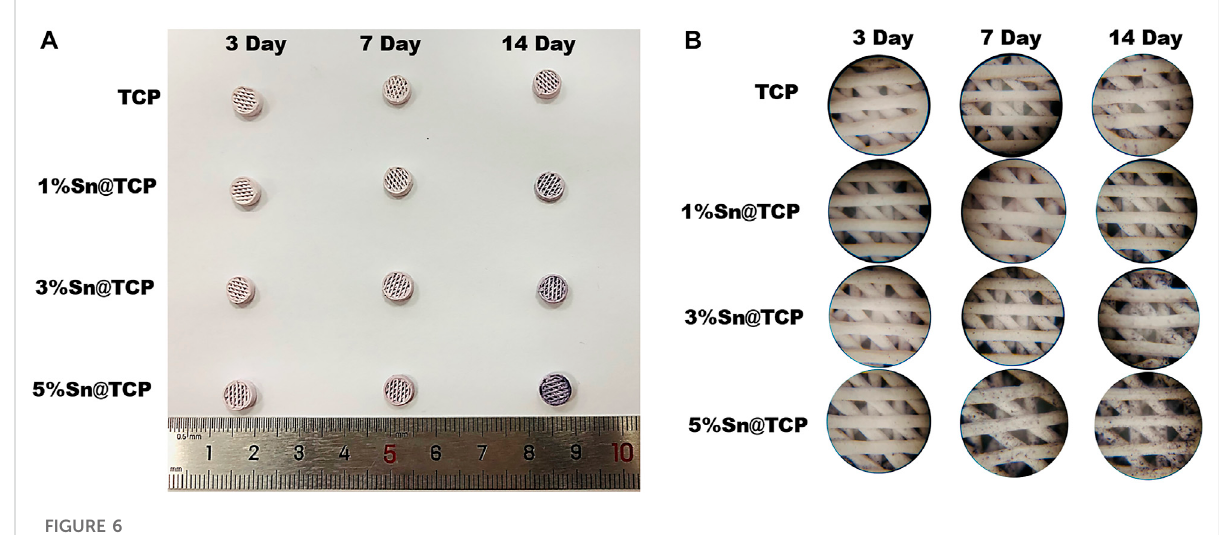
FIGURE 6 Osteoblast inducing activity of Sn@TCP scaffolds during 14 days (A) The photographs of ALP staining of Sn@TCP scaffolds in 3 days, 7 days and 14 days (B) The magni fi ed photographs of ALP staining of Sn@TCP scaffolds in 3 days, 7 days and 14 days (Magni fi cation 4